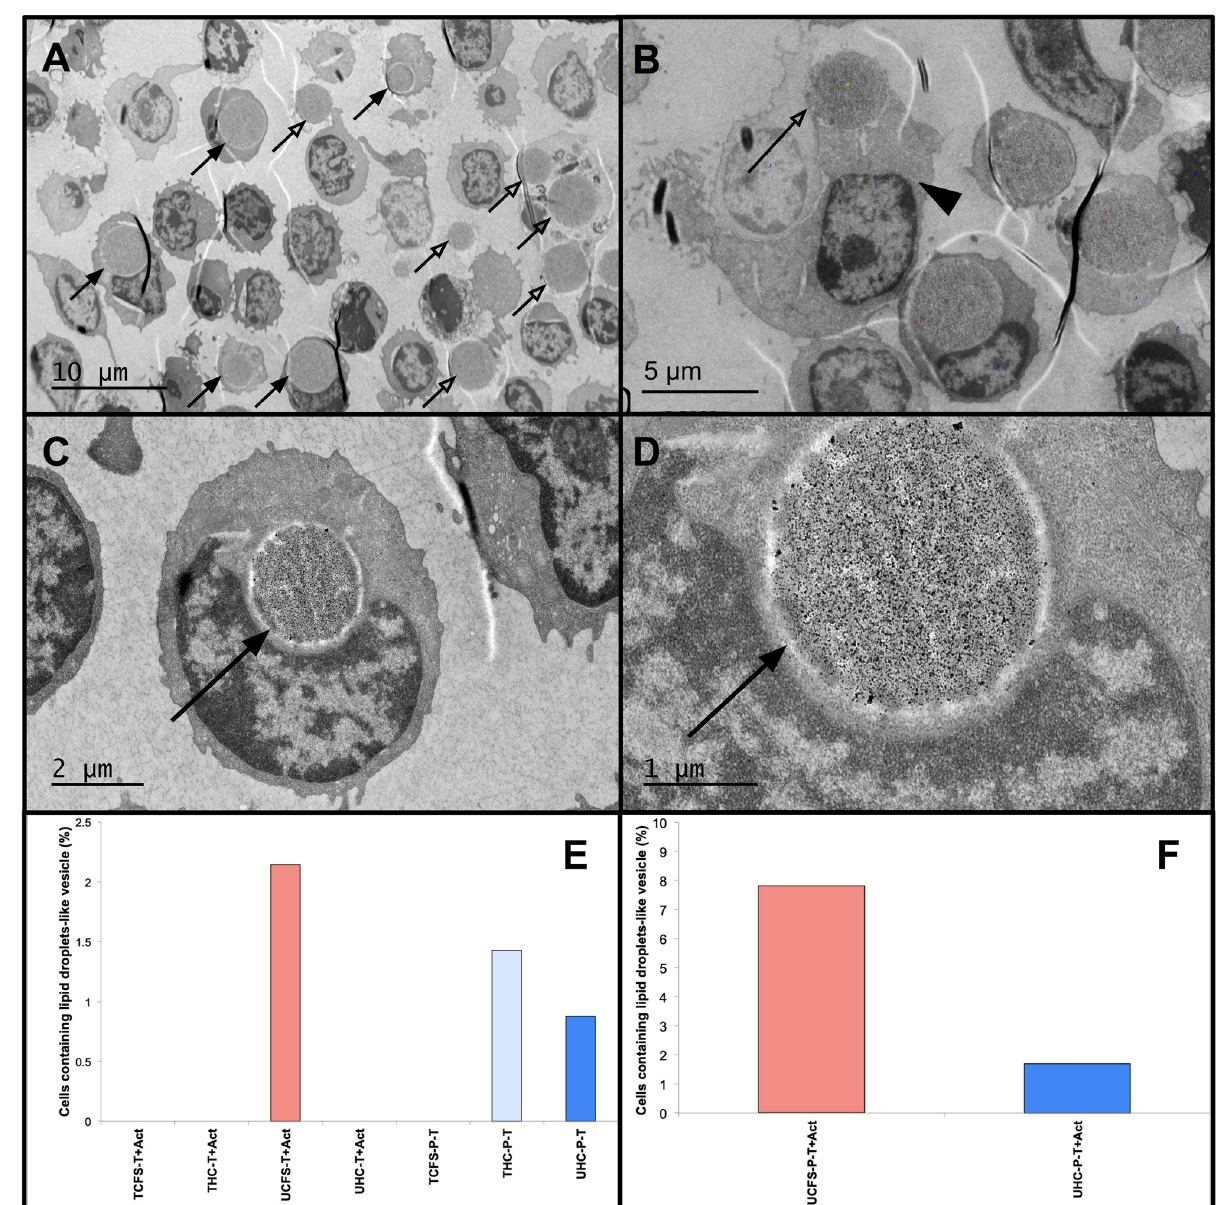
Fig 3. TEM analysis of giant lipid droplet-like vesicles within PBMC subpopulations. The micrographs from stimulated PBMC lacking T cells from the unrelated extremely severe ME/CFS patient (UCFS-P-T+Act) showing: (A) the presence of intracellular giant lipid droplet-like vesicles (arrows) and extracellular giant lipid droplet-like vesicles (open arrows) at 500x magnification, (B) an immune cell releasing/engulfing (arrowhead) a giant lipid droplet-like vesicle (open arrow) at 1000x magnification, (C) image of an immune cell containing a giant lipid droplet-like vesicle (arrow) at 2000x magnification, (D) the magnified image of the giant lipid droplet-like vesicle shown in C. (E) Percentage of stimulated T cells and unstimulated PBMC lacking T cell subpopulation that contain intracellular giant lipid droplet-like vesicles. (F) Percentage of stimulated PBMC lacking T cell subpopulation that contain intracellular giant lipid droplet-like vesicles in extremely severe unrelated ME/CFS and unrelated age- and gender-match healthy control.